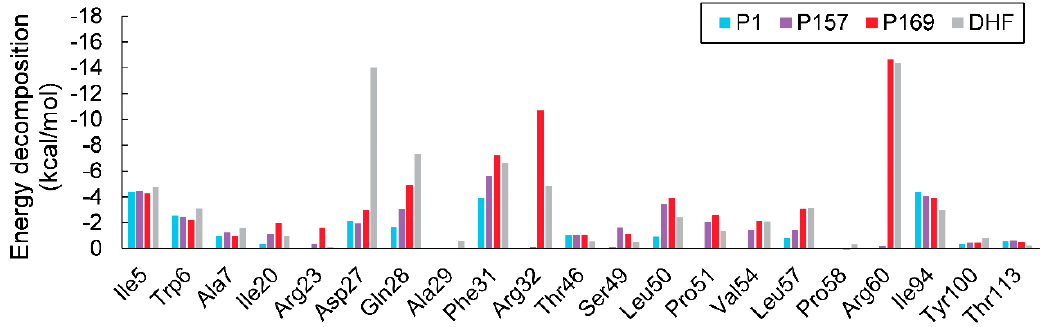
Figure 8. Energy decomposition of amino acid residues in the binding site towards the ligand in each ternary complex: P1 (blue bars), P157 (purple bars), P169 (red bars), and DHF (gray bars).